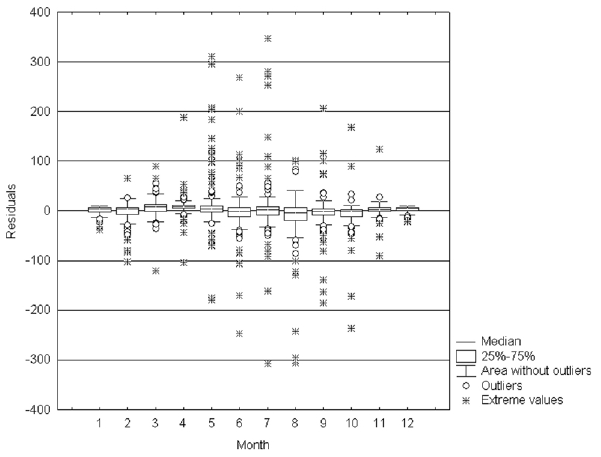
Fig. 3. Flow duration curves for measured and simulated discharges at gauge Xingshan during the calibration period. Fig. 4. Box-and-Whisker plot for residuals per